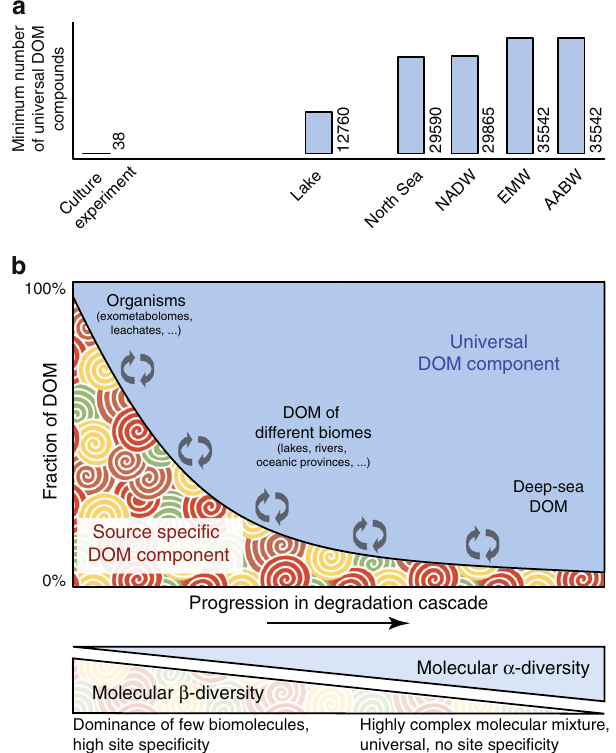
Fig. 4 Conceptual view of DOM composition along the degradation and mixing cascade. a Minimum number of universal DOM compounds that are detectable in the respective samples. The number of compounds was estimated by multiplying the minimum number of isomers by the number of detected molecular formulae common to the samples with highest degradation state, AABW and EMW (see also Supplementary Fig.